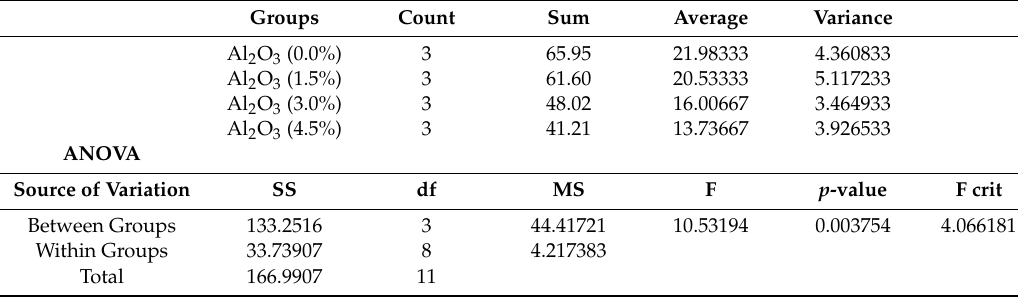
Table 8. Water Absorption values of Al 2 O 3 -UF MDF for various treatments.